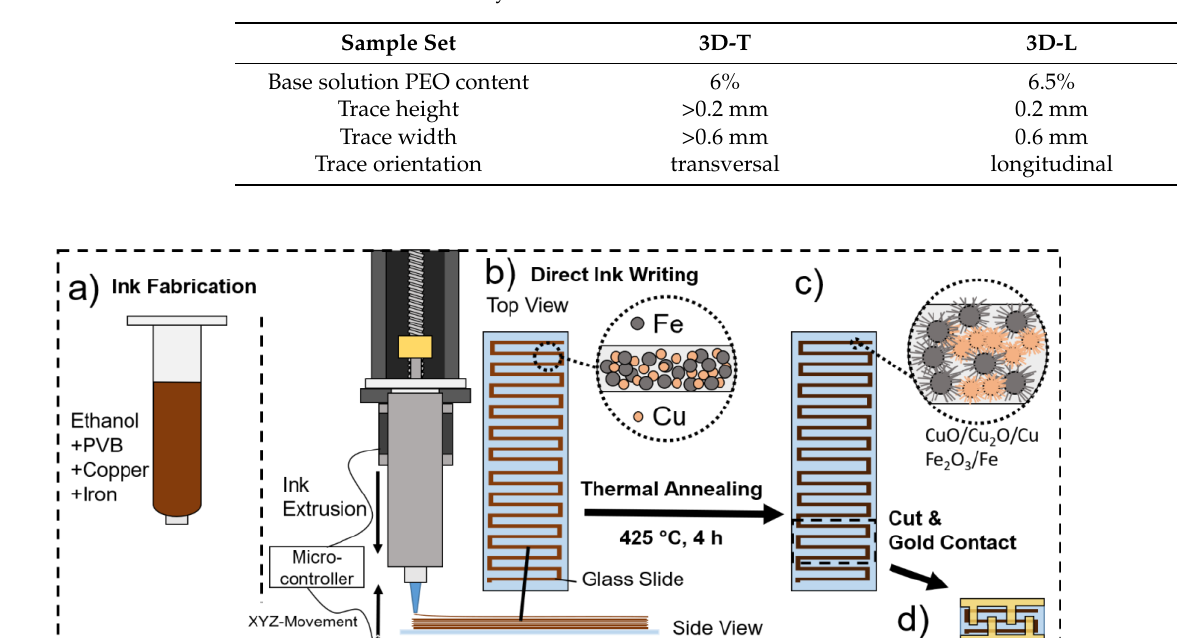
Figure 2. Representing sensor design flow: ( a ) ink preparation by mixing Cu and Fe microparticles based powder in C 2 H 5 OH, stirring in PVB until homogeneous, and then the ink is introduced into the depicted cartridges; ( b ) direct ink writing via piston-driven syringe pumps in 3D-printing DIW setup. Layer by layer fabrication of meander-like Cu-Fe stripes/traces. ( c ) The substrate with the printed device is mounted in a furnace at ambient temperature and heated, thus the semiconducting oxides appear. ( d ) Developed substrates are coated with Au through a mask and then cut as a separate device for the next studies [19]. “Reprinted with permission from {Siebert, L.; Wolff, N.; Ababii, N.; Terasa, M.-I.; Lupan, O.; Vahl, A.; Duppel, V.; Qiu, H.; Tienken, M.; Mirabelli, M.; Sontea, V.; Faupel, F.; Kienle, L.; Adelung, R. Facile fabrication of semiconducting oxide nanostructures by direct ink writing of readily available metal microparticles and their application as low power acetone gas sensors. Nano Energy 2020 , 70 , 104420, https://doi.org/10.1016/j.nanoen.2019.104420}, with permission from